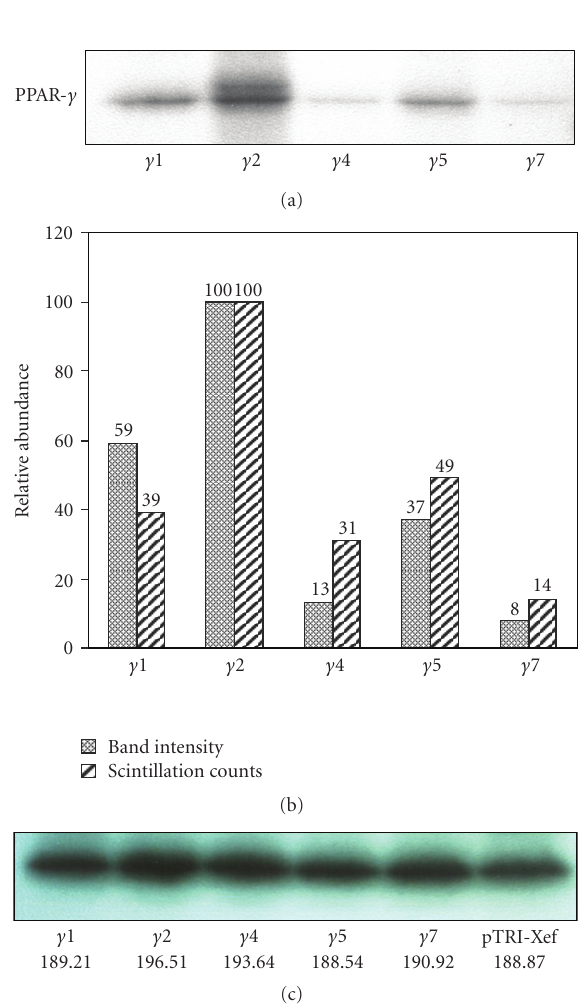
Figure 2: In vitro Transcription-Translation. Templates for the full- length PPAR- γ 1, γ 2, γ 4, γ 5, and γ 7 splice variants were used to perform coupled in vitro transcription and translation reactions as described in “Methods”. Products were separated using SDS-PAGE. (a). The gel was dried and exposed to x-ray film to visualize in vitro labeled protein products. (b). (dotted bars) Band intensities were quantitated and the most optically dense band was set to 100. (b). (hatched bars) After the coupled in vitro transcription- translation reaction, labeled proteins were precipitated using TCA and the radioactivity in the precipitate was measured using a liquid scintillation counter. The highest counts were set to 100. (c). Templates for the γ 1, γ 2, γ 4, γ 5, and γ 7 splice variants were mixed with a pTRI-Xef template and in vitro transcription and translation reactions were performed on each mixture. Bands were resolved by SDS-PAGE. The bands for pTRI-Xef are shown with the band intensities reported below each